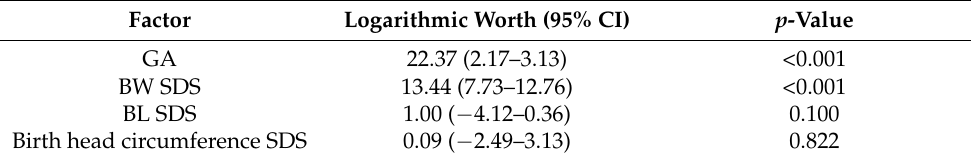
Table 4. Multivariate